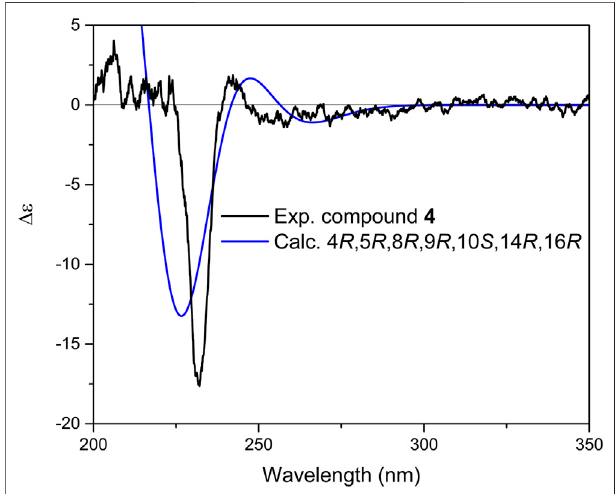
FIGURE 7 | Comparison of experimental and calculated ECD spectra of compound 4 at TD-DFT/B3LYP/6-31+G(d,p) basis set and level of theory in